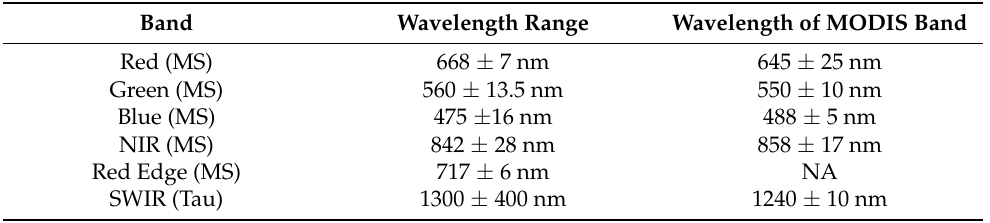
Table 2. Wavelength Bands of the Micasense (MS) and Tau Sensors, with MODIS Bands for Compari-